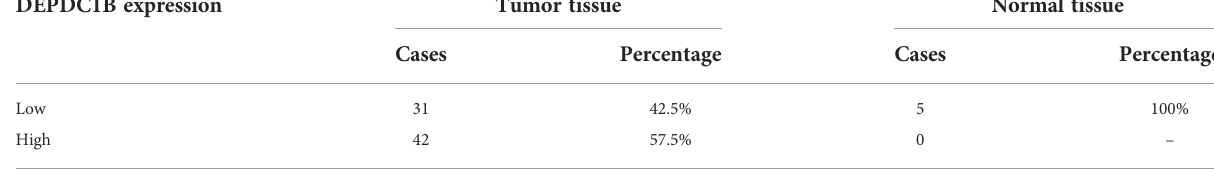
TABLE 1 Expression patterns of DEPDC1B in CCA tissues and normal tissues revealed in immunohistochemistry analysis.